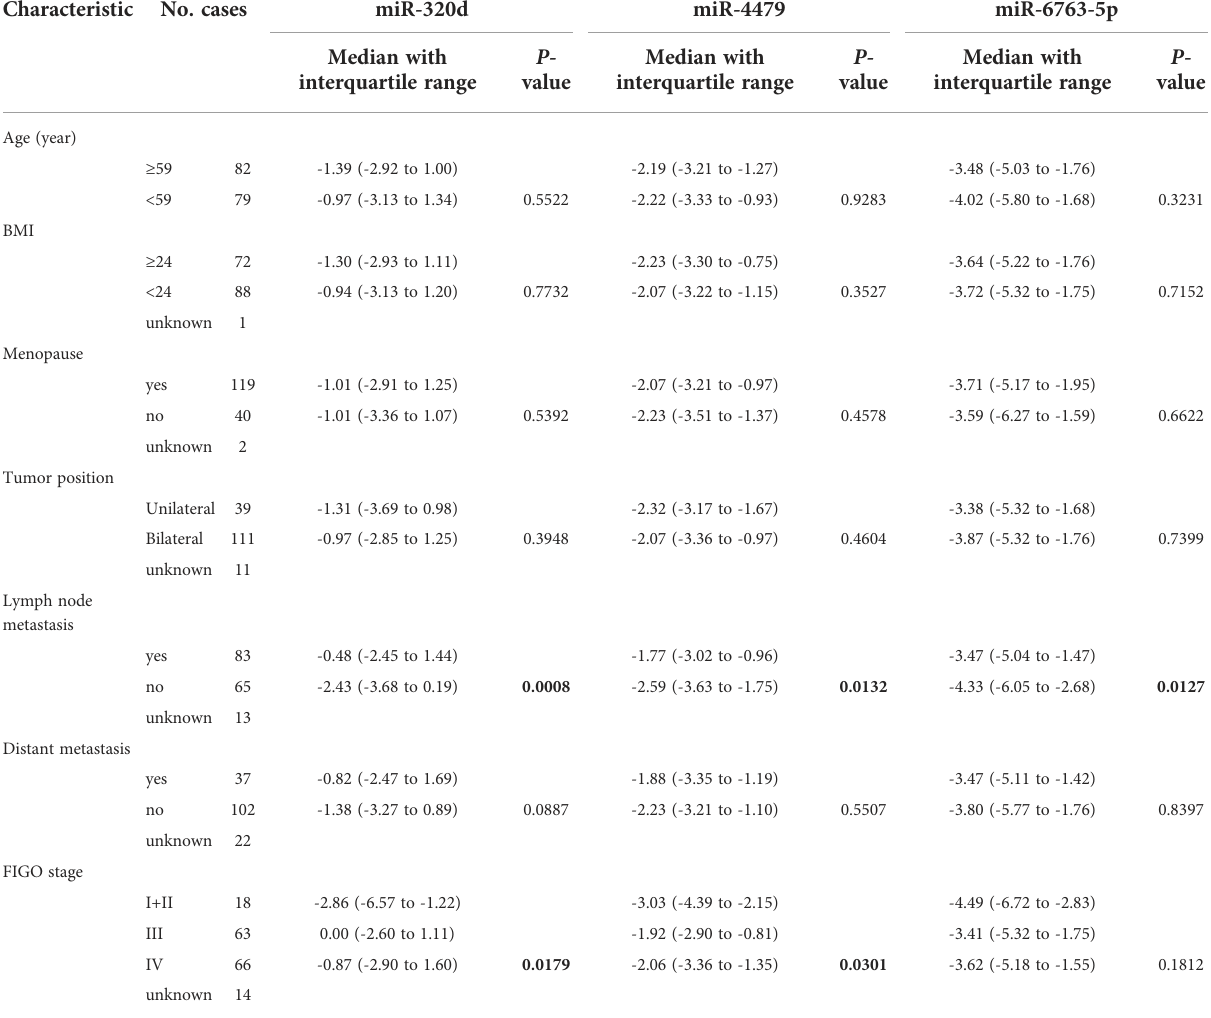
TABLE 1 Characteristics of EOC patients for differentially expressed exosomal miR-320d, miR-4479, and miR-6763-5p.